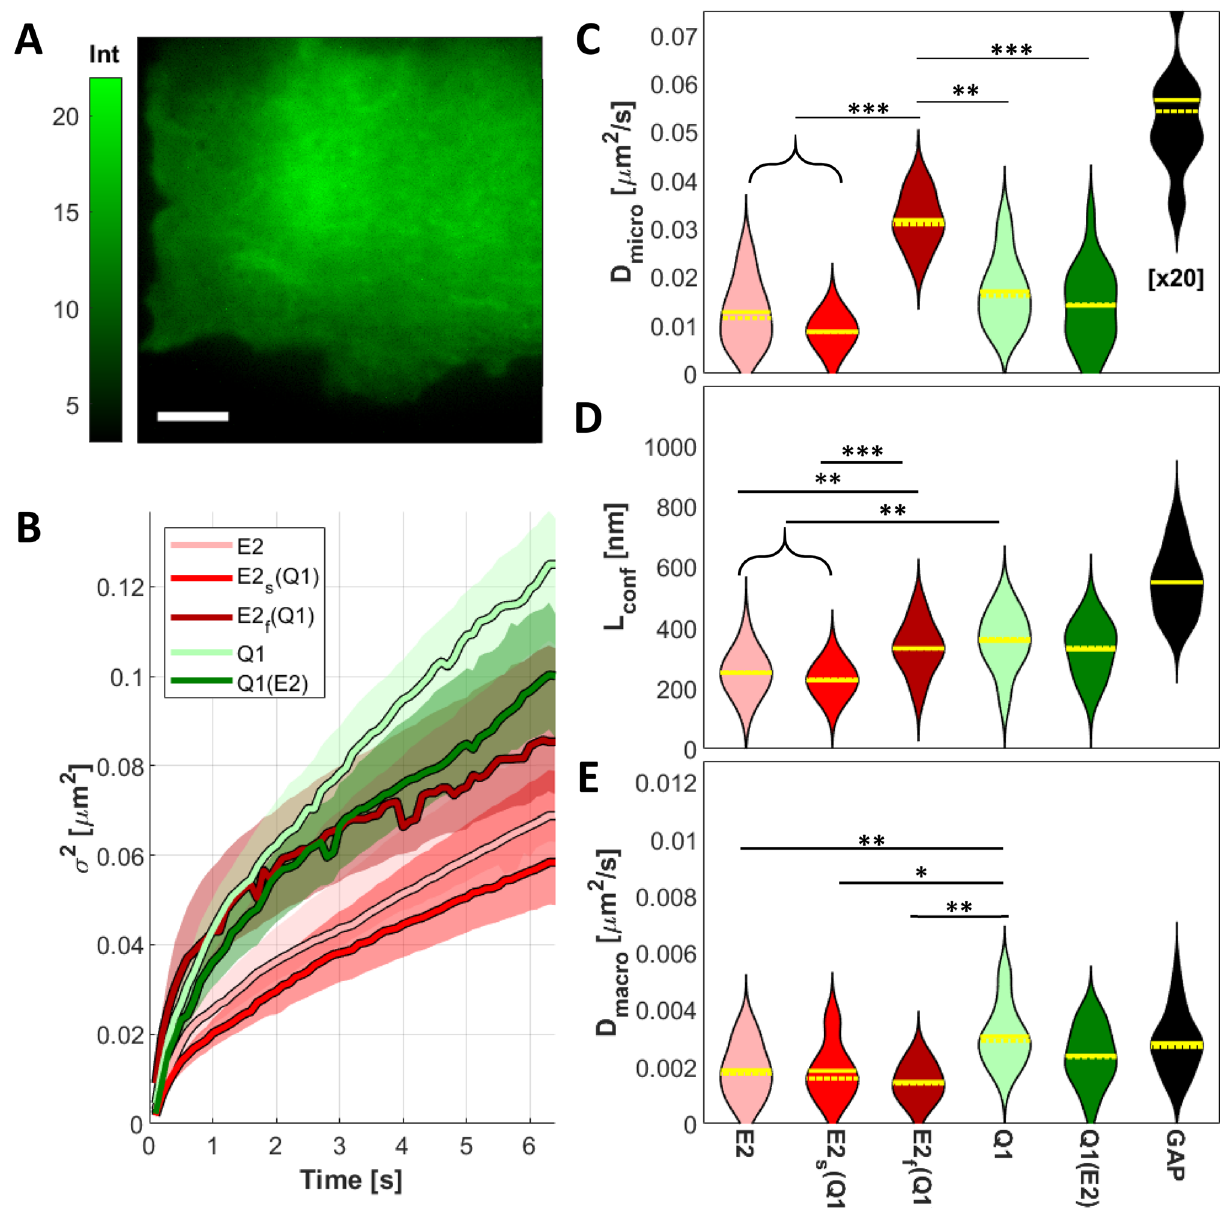
Figure 3. Representative average intensity image ( A ) of a CHO cell transfected with KCNE2-mEGFP. Average iMSD curves (colored curves) (B) with 95% confidence interval (shaded areas) for the conditions considered. Violin plots of the parameters obtained from the fitting with a transient confined model: D micro ( C ), L conf ( D ) and D macro ( E ). The value of D micro for GAP-mEGFP is 20 times the one shown in the graph (reported as [× 20]). Scale bar in A is 5 µm. Solid and dashed yellow lines represent the mean and the median of the distributions, respectively. Asterisks represent P -values < 0.05 (*), < 0.01 (**) and < 0.001 (***). P -values were obtained from Tukey’s multiple comparison test. The conditions comprised in brackets are not statistically different ( P > 0.5) among them but they are statistically significant compared to the other condition considered, with the displayed P